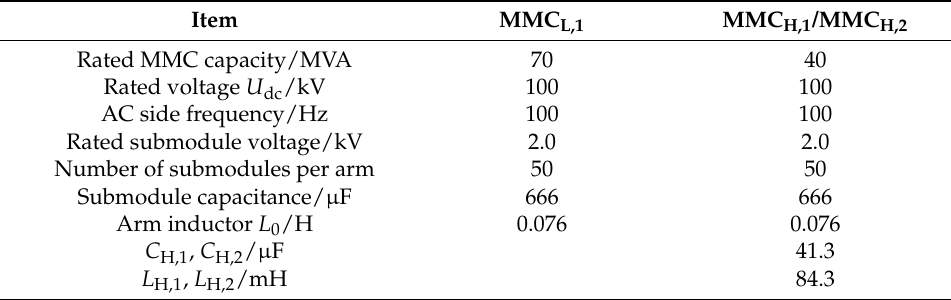
Table 3. Parameter in the MCAT.